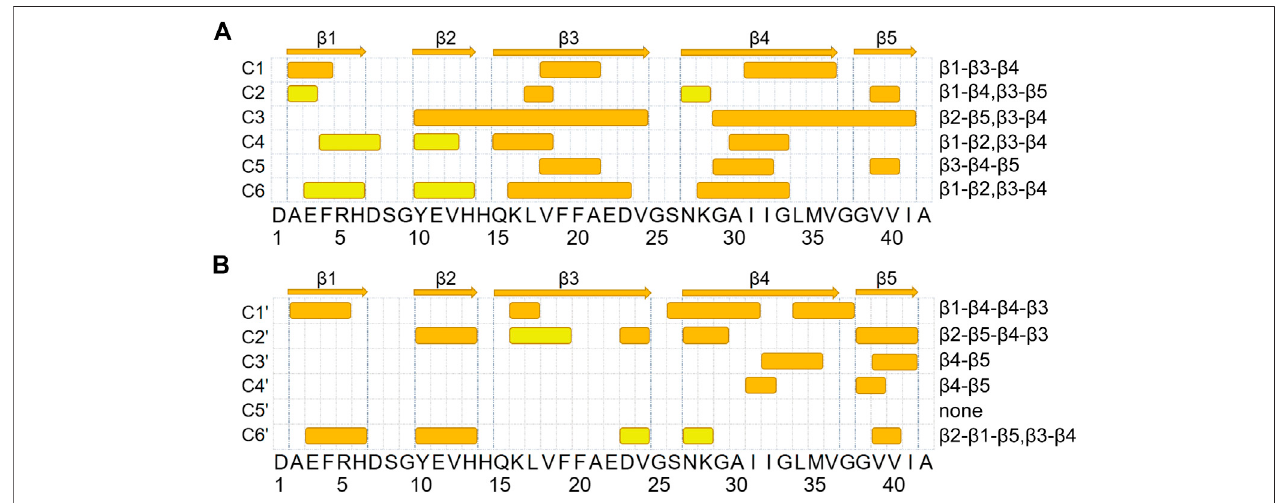
FIGURE3| β -sheetassociationsforA β 42andA β 42+HSAaredisplayedin (A,B) ,respectively. β -strandsformedintherepresentativeconformationsofthetopsix most-populated clustersareshown withcoloredstrips. Thecorrespondingsnapshot ofeach conformationisshown in Figure2 . β -strands thatassociate intothesame β -sheet are paired with the same color. At the top, fi ve β -segments are represented by arrows.